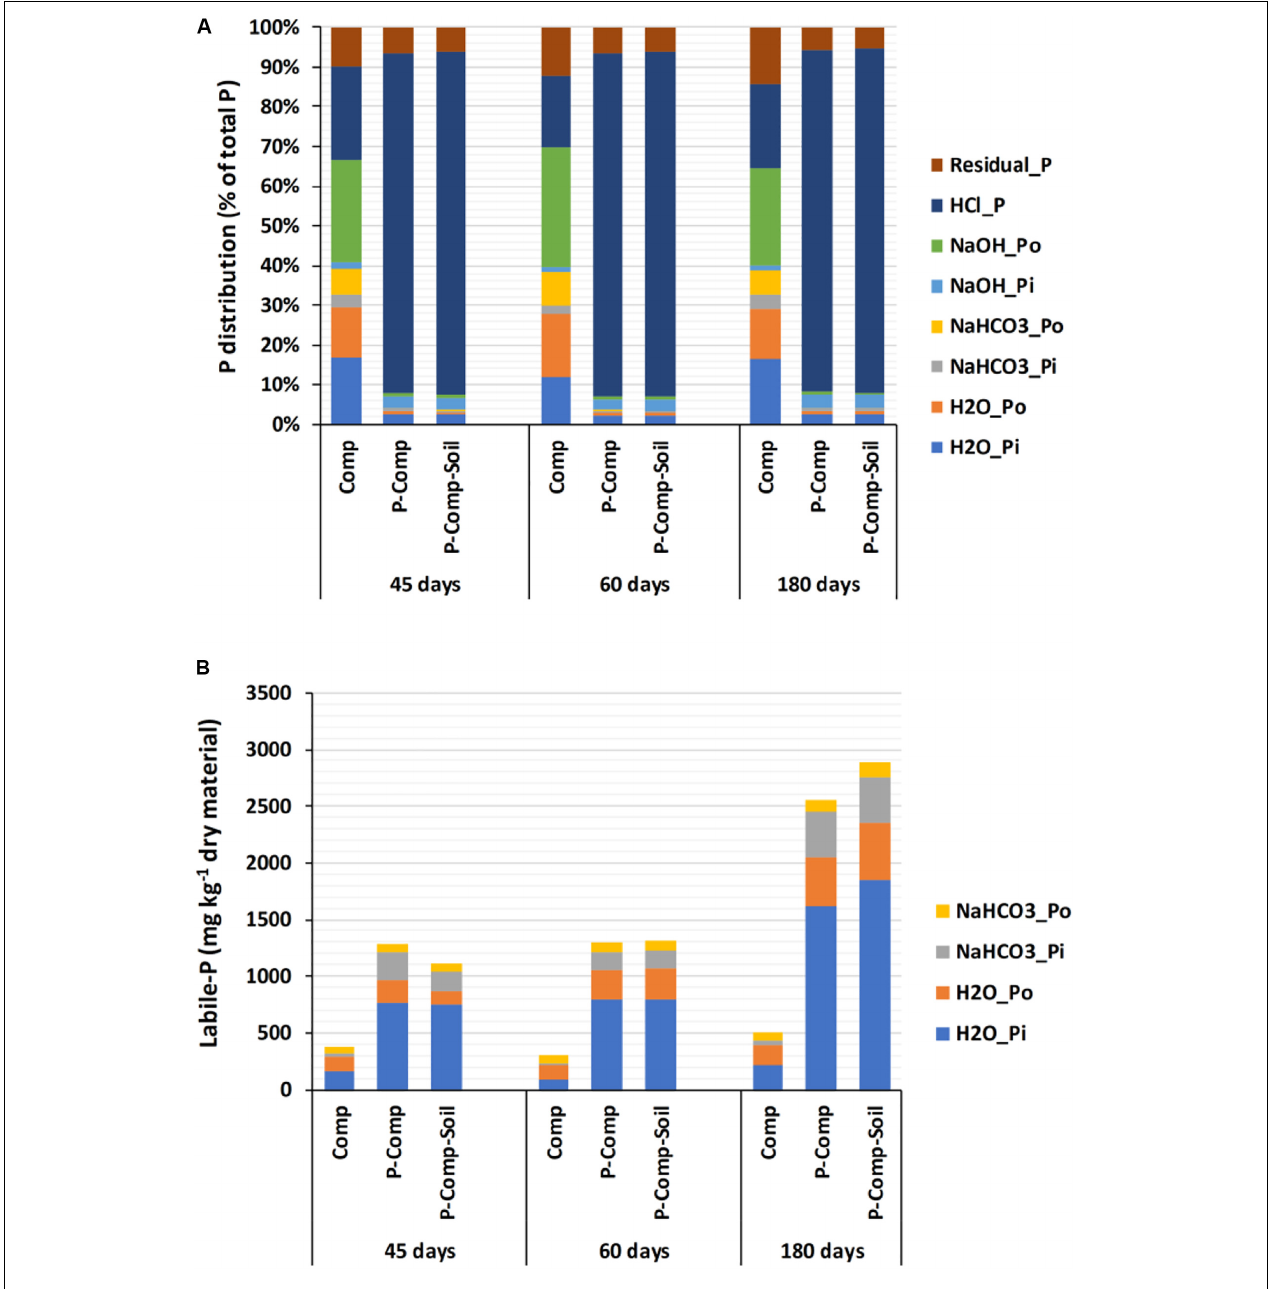
FIGURE 1 | Distribution of all P fractions in composts (A) , and concentrations of labile-P fraction during the composting (B) . Sampling was carried out at 45, 60, and 180 days. The data of each treatment at a given sampling period are averages of 3 replications per treatment. Comp, sole compost with sorghum straw as organic material; P-Comp, Burkina phosphate rock (BPR)-enriched compost; P-Comp-Soil, BPR-enriched composted with addition of rhizosphere soil.